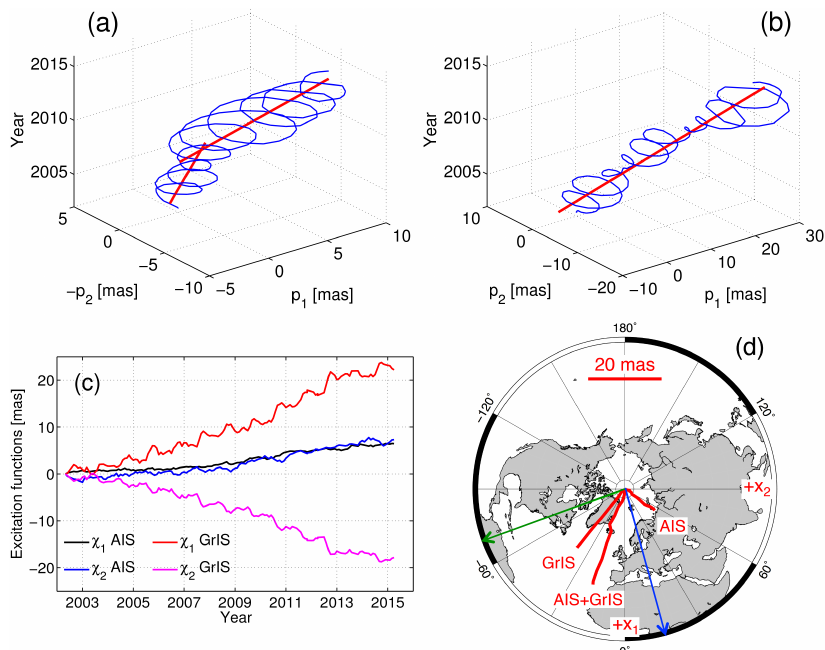
Figure 6. Polar motion during the GRACE period. Monthly pole positions (with respect to April 2002), (p 1 ,p 2 ) , excited by (a) AIS and (b) GrIS mass loss in the right-handed coordinate system (x 1 ,x 2 ) (see d ). Red lines show the average drift directions. A kink is apparent for the AIS. (c) Mass excitation functions, χ 1 and χ 2 , associated with individual ice sheets. (d) Annual pole positions, after removing Chandler wobbles, with respect to the 2002 position. For comparison, the observed long-term (green arrow; Mitrovica et al., 2006) and recent (2005–2011; blue arrow; Chen et al., 2013) drift directions are also shown. Note that 1 mas ≈ 3 .